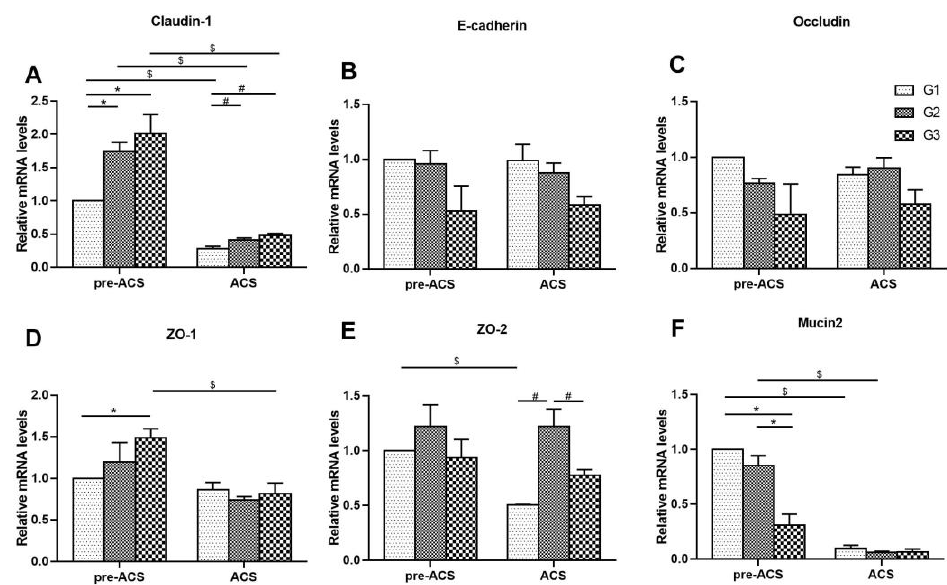
Figure 5. The mRNA levels of intestinal barrier genes Claudin-1 ( A ), E-cadherin ( B ), Occludin ( C ), ZO-1 ( D ), ZO-2 ( E ), and Mucin2 ( F ) in ilea of broilers before and after ACS. Data were presented as mean ± SD ( n = 6). Different labels represent significant differences ( p < 0.05). pre-ACS (*), ACS (#) and before and after ACS ($). G1, cold stimulation for 0 h; G2, cold stimulation for 3 h; G3, cold stimulation for 6 h.